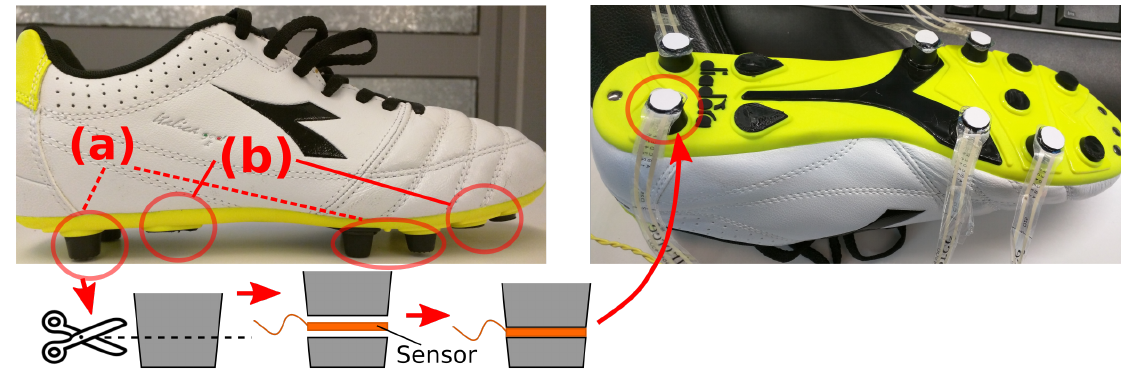
Figure 4. Proof-of-concept Prototype Shoe Based on SSFCs ( a ) Cleats ( b ) Removed Extra